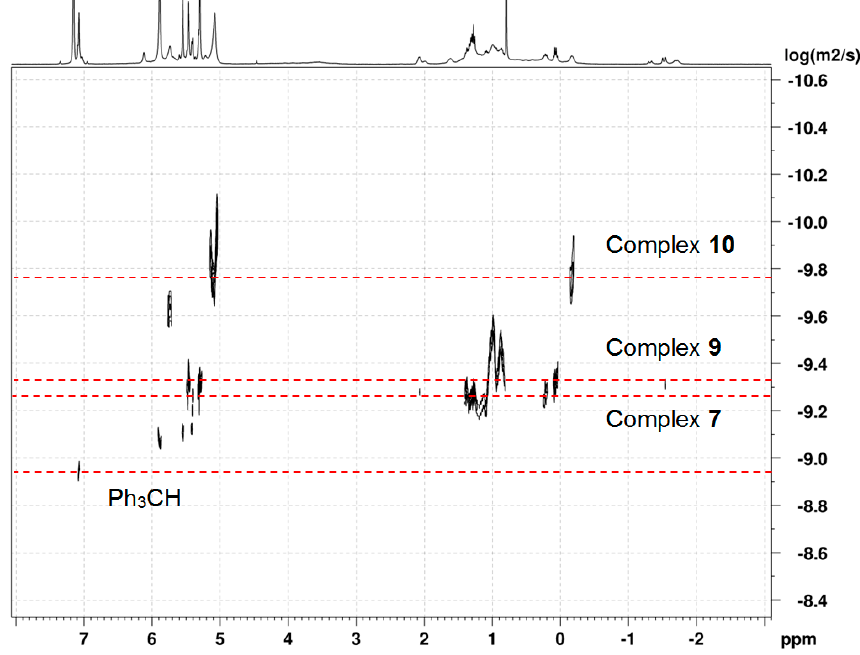
Figure 3. DOSY of the [Cp 2 ZrH 2 ] 2 -ClAlEt 2 -B(C 6 F 5 ) 3 (1:3:0.5) system in C 6 D 6 (T = 297.1 K), heavy phase .